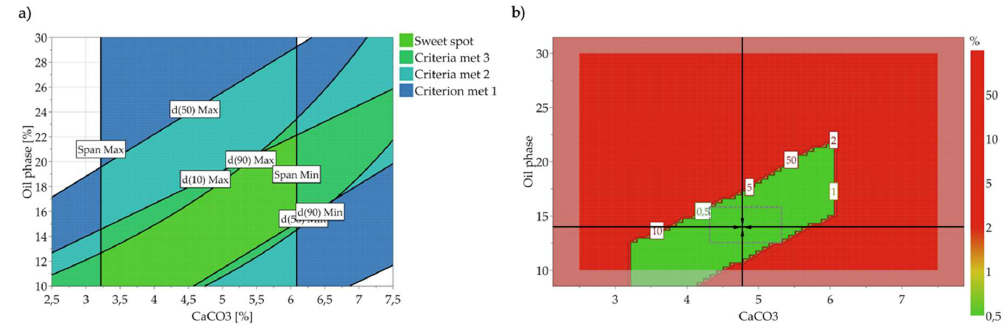
Figure 5. Plot evidence: the ( a ) Sweet Spot and the ( b ) Design Space for the CC-based emulsion.